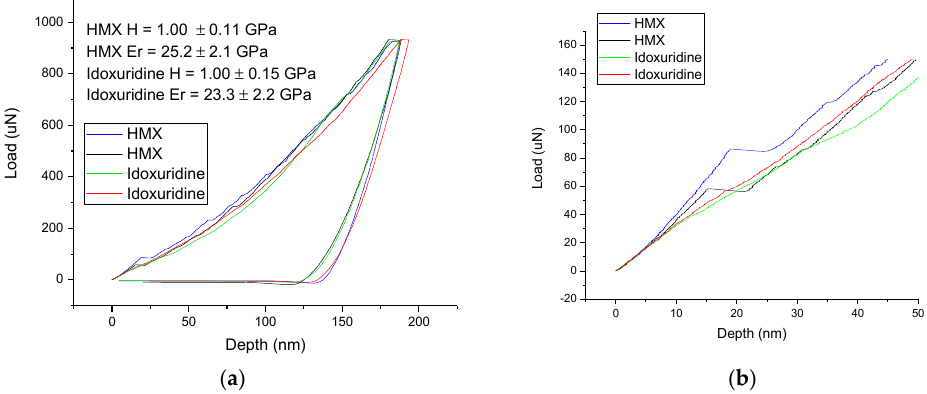
Figure 1. ( a ) Typical load-depth curves for HMX and idoxuridine, with indentations in two random crystals of each material shown. Modulus values reported in the figure are the average values of ≈ 20 indents in each material. ( b ) The same load-depth curves as in ( a ), showing only data below 150 μ N. Note there is evidence of yield point behavior at loads less than 100 μ N, and multiple yield events on loading, which are common in materials with limited slip systems.